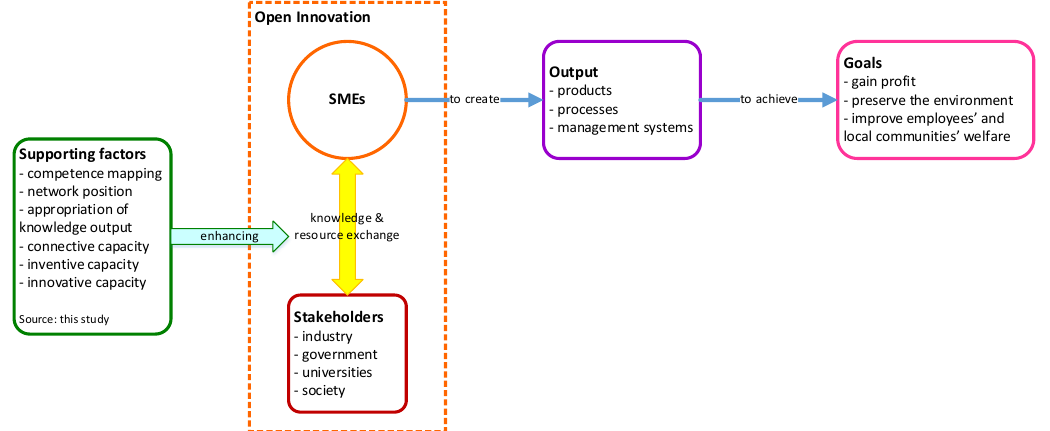
Figure 3. SMEs sustainability with open innovation.